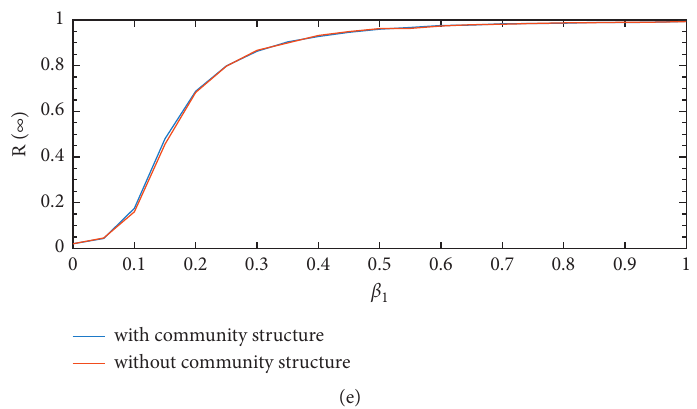
Figure 4: The influence of epidemic transmission rate on the coupled disease-awareness model. (a) Density of infected individuals in the physical layer as a function of time. (b) Density of recovered individuals in the physical layer as a function of time. (c) Density of aware individuals in the virtual layer as a function of time. (d) Density of recovered individuals in the virtual layer as a function of time. (e) The final density of recovered individuals in the physical layer under different disease transmission rates for the virtual contact networks with or without community